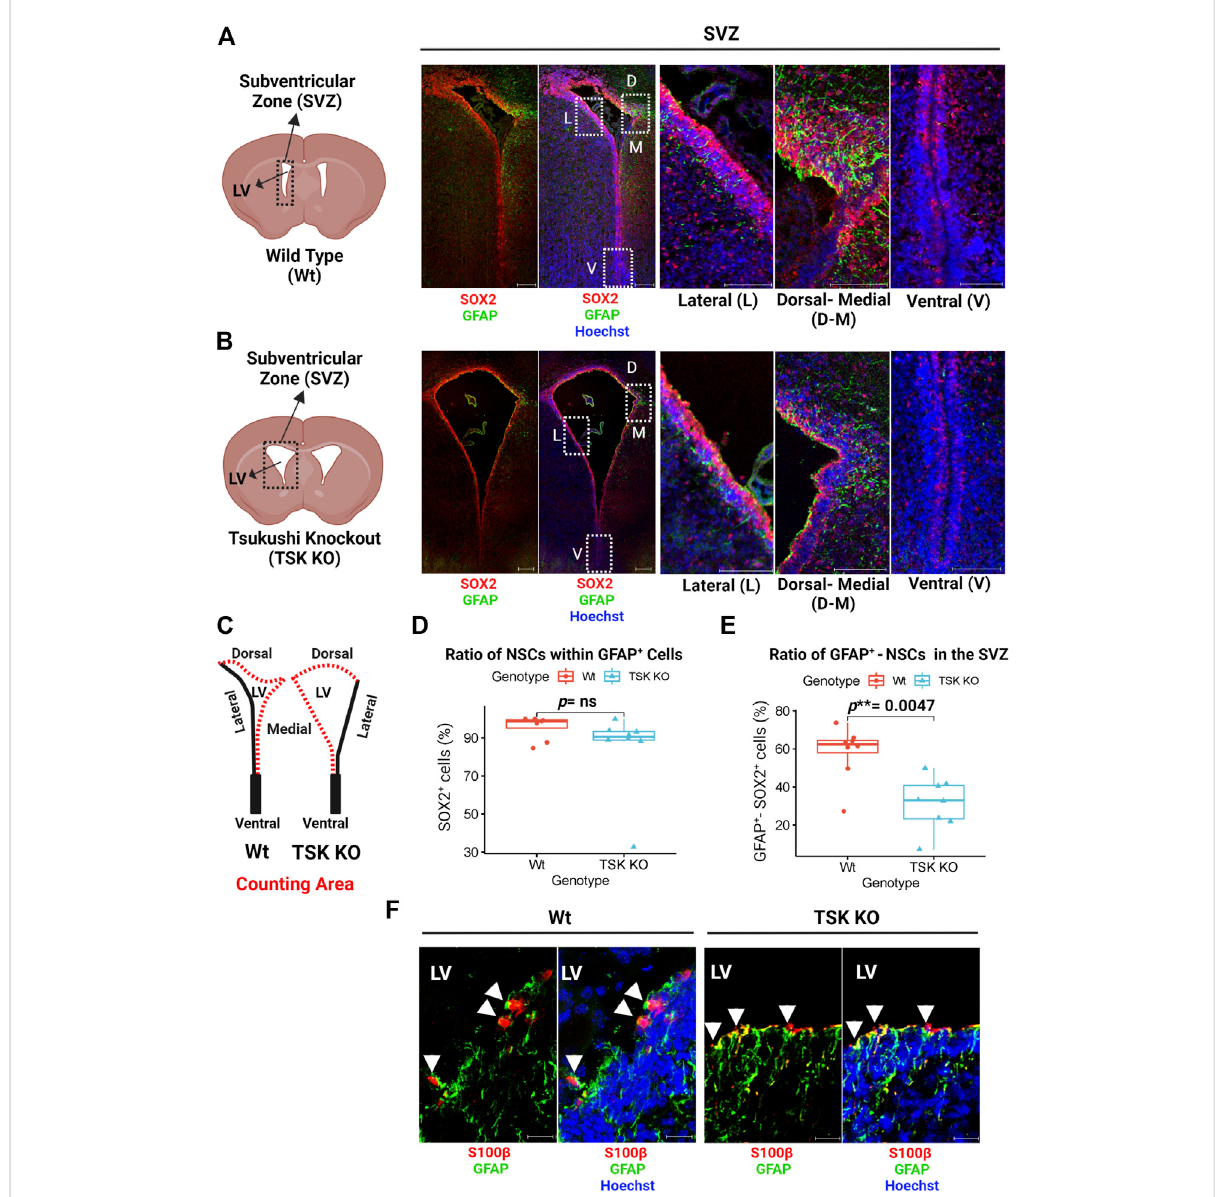
FIGURE 1 Tsukushi de fi ciency disrupts GFAP+ NSCs. (A) Representing cartoon and images of P3 stage Wt SVZ immunostained for GFAP (Green), SOX2 (Red)andNuclei(Hoechst,Blue).Scalebar=200 μ m(wholeSVZ),100 μ m(enlargedviews). (B) RepresentingcartoonandimagesofP3stageTSKKO SVZ immunostained for GFAP (Green), SOX2 (Red) and Nuclei (Hoechst, blue). Scale bar = 200 μ m (whole SVZ),100 μ m (enlarged views). (C) Cartoons of Wt and TSK KO SVZ showing the area for cell counting. (D) Percentage distribution of SOX2 + cells within GFAP + cell population in SVZ. Distribution is shown by box plot with jitters. Each dot represents a SVZ. Number of brain samples: nTSK KO = 4, nWt = 4. (E) Percentage distributionfor theGFAP + -SOX2 + doublepositive SVZcells.Distribution isshownbyboxplotwithjitters.EachdotrepresentsaSVZ.Numberofbrain samples: nTSK KO = 4, nWT = 4. (F) IHC analysis for GFAP (Green) expression in S100 β + (Red) cells in SVZ at P3. Cell nuclei are stained with Hoechst (Blue).ArrowheadindicatesGFAP + -S100 β + doublepositivecells. Scalebar20 μ m.LV=Lateralventricle. Theimagefocusesonthemedialsideofthe SVZ. All the statistical signi fi cance is denoted by p -value using Wilcoxon rank sum test. P * < 0.05, p** < 0.01, p*** < 0.001, p ≥ 0.05 (ns = not signi fi